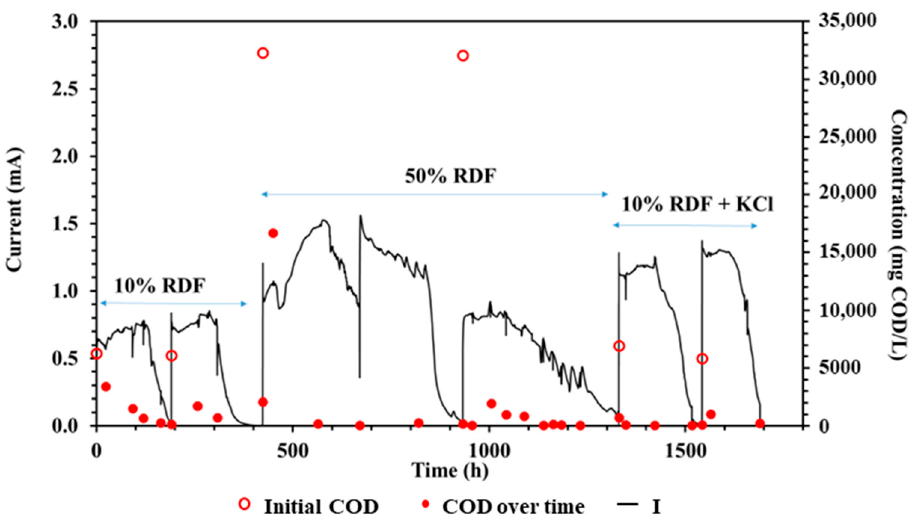
Figure 6. Electric current output and COD concentration versus time for the MFC operation with RDF (10% diluted RDF—left, 50% diluted RDF—middle, 10% diluted RDF with KCl—right).